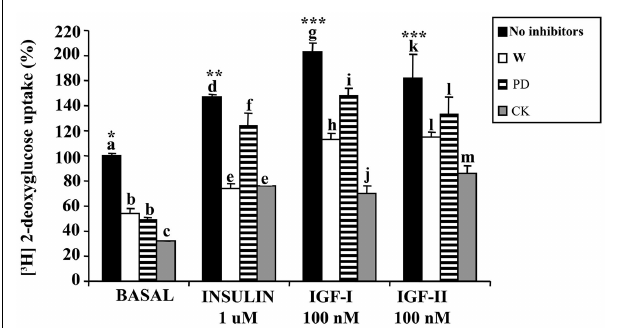
FIGURE 3 | Effect of inhibitors on 2-deoxyglucose uptake in sea bream myocytes. Cells at day 5 were pre-incubated for 30min with wortmannin (W, 1 μ M) or PD-98059 (PD, 50 μ M). Next, IGF-I or IGF-II (both at 100nM) or insulin (1 μ M) were added for 30 additional min. Cytochalasin B (CK, 20 μ M) was incubated for 30min. Results are expressed as percentage of stimulation over basal levels and mean ± SE ( n = 3 experiments).